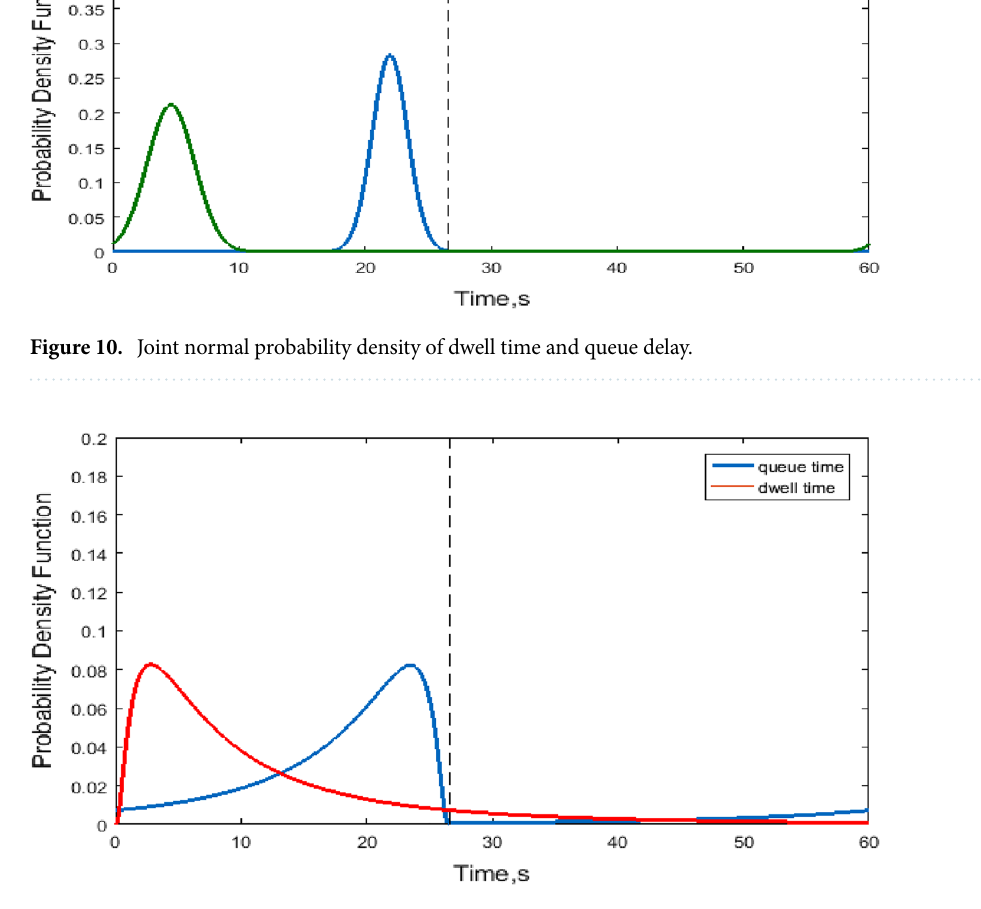
Figure 11. Joint lognormal probability density of dwell time and queue